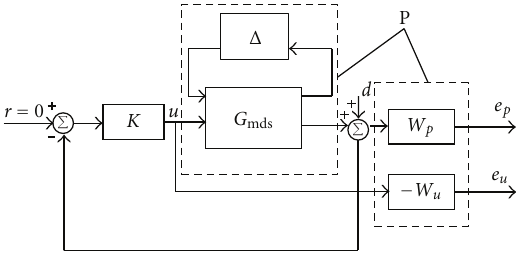
Figure 3: Block scheme of plant showing the new plant.